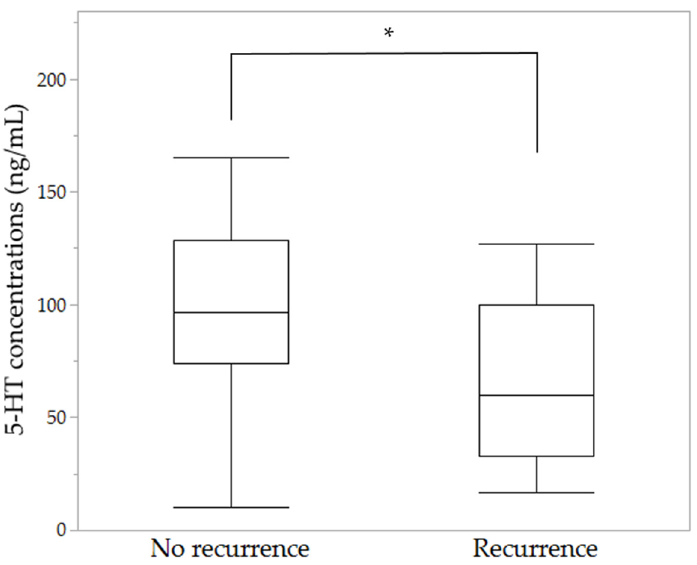
Figure 3. Comparison of 5-HT concentrations based on the presence of CSC recurrences; 5-HT concentrations were significantly lower in patients with CSC recurrence (* p = 0.001).